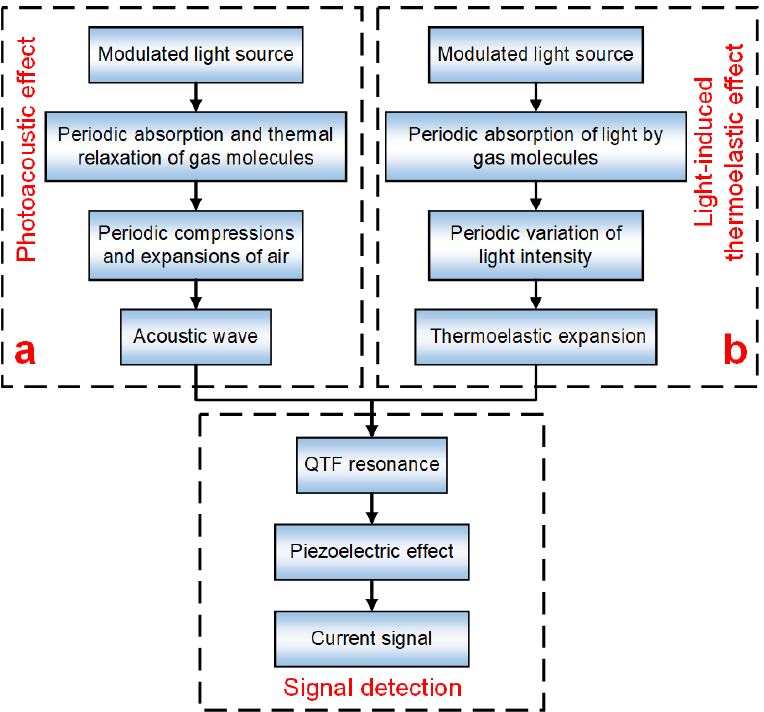
Figure 1. Functional block diagram: ( a ) QEPAS; ( b ) LITES.